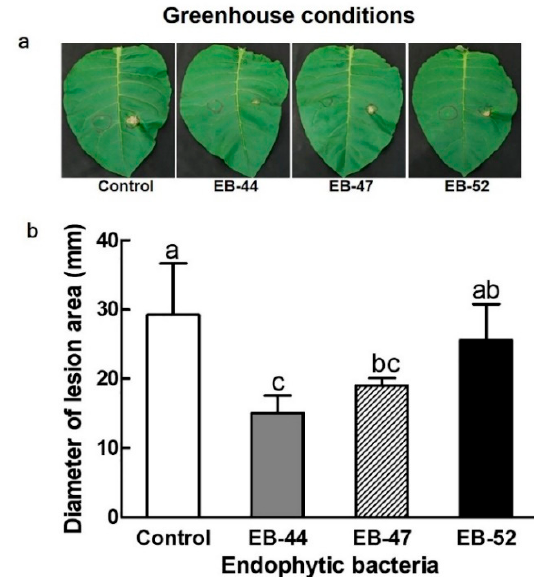
Figure 3. The effect of salicylic acid-producing endophytic bacteria on the resistance of Nicotiana tabacum against Pseudomonas syringae pv. tabaci (Pst). Nicotiana tabacum plants grown from seeds treated with 10 mM MgCl 2 (control), EB-44, EB-47, or EB-52 for 3 h were evaluated for disease incidence in 4-week-old leaves infiltrated with 0.1 mL of Pst ; infection diameter was measured 6 days after inoculation. ( a) Left: 10 mM MgCl 2 treatment as control; right: 0.1 OD 600 Pst . ( b ) Lesion diameter. Data represent means ± standard deviations of four independent replications for each treatment. Means with different letters are significantly different at p < 0.05 by Duncan’s multiple range test.